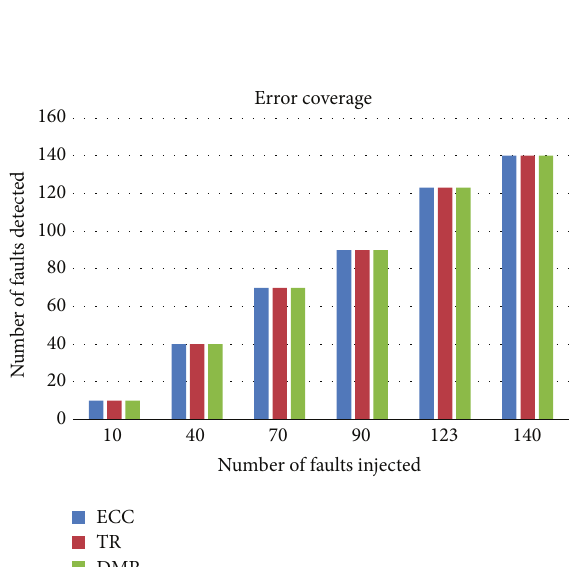
Figure 6: 2-bit injection and detection.